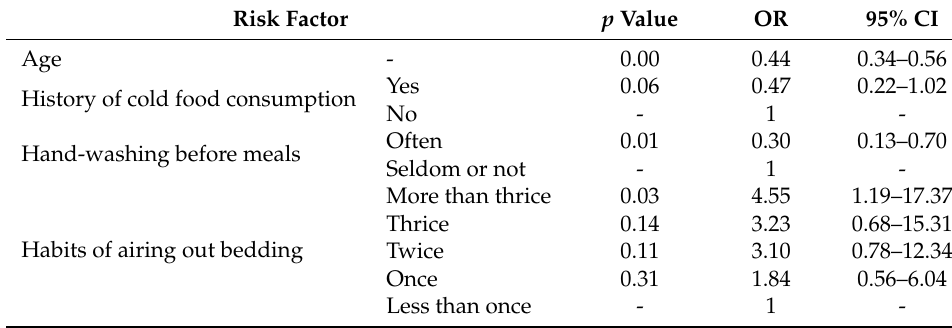
Figure 1. The receiver operating characteristic curve of age, hand-washing before meals and airing out bedding for the ability to differentiate the HFMD cases from the control individuals. AUC: 0.895. Table 3. Further multivariate analysis on factors associated with HFMD infection in preschool-aged children.